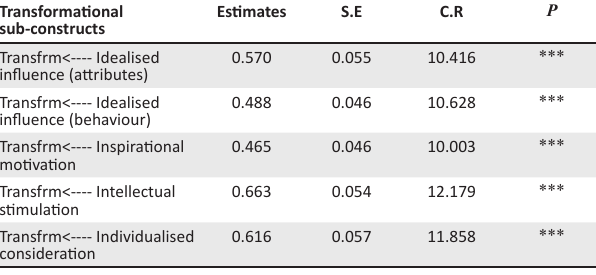
TABLE 4: Structural model parameter estimates and p -values for transformational leadership and its sub-constructs. Transformational sub-constructs